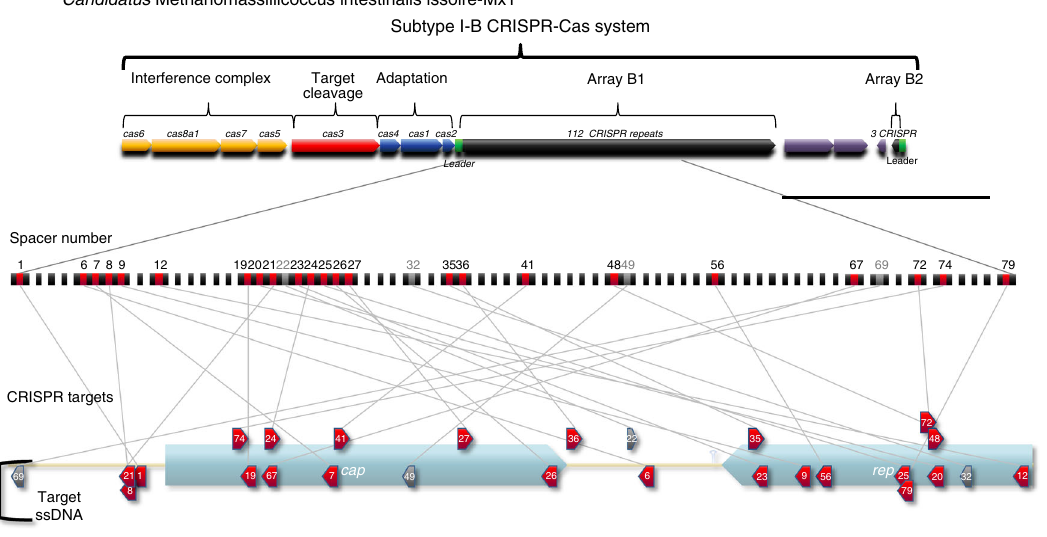
Fig. 1 Clustered Interspaced Short Palindromic Repeats (CRISPR)-Cas Subtype I-B in Candidatus M. intestinalis and its targets in smacoviruses. The CRISPR- Cas subtype I-B in Ca . M. intestinalis is represented. Related cas genes are grouped and coloured according to functional categories: adaptation ( cas1 – 2 and cas4 ), target cleavage ( cas3 ) and formation of interference complex ( cas6 , cas8a1 , cas7 and cas5 ). Cas8a1 would belong to subtype I-A. Two repetitive arrays are found in opposite orientations, here named B1 (112 repeats) and B2 (3 repeats), with putative leader sequences, from where transcription would start. Array B1 is ampli fi ed and similarities of spacers to sequences in smacoviruses indicated. A smacovirus 'archetype' is depicted where targets are represented with their relative positions to genes (see Methods). Similar sequences that are in the same orientation of spacers point right and vice versa. Smacoviruses are circular single-stranded DNA (ssDNA) virus with just two genes ( rep and cap ). Targets in the ssDNA are represented below the viral genome, and targets in the complementary strand above. Targets in red were found with local – global alignments, while targets in grey only with local alignments. All arrows point in the sense of predicted transcription (for targets transcription of CRISPR RNA (crRNA)). Scale bars are 5 kb (above) and 0.5 kb (bottom). Non-CRISPR genes are coloured